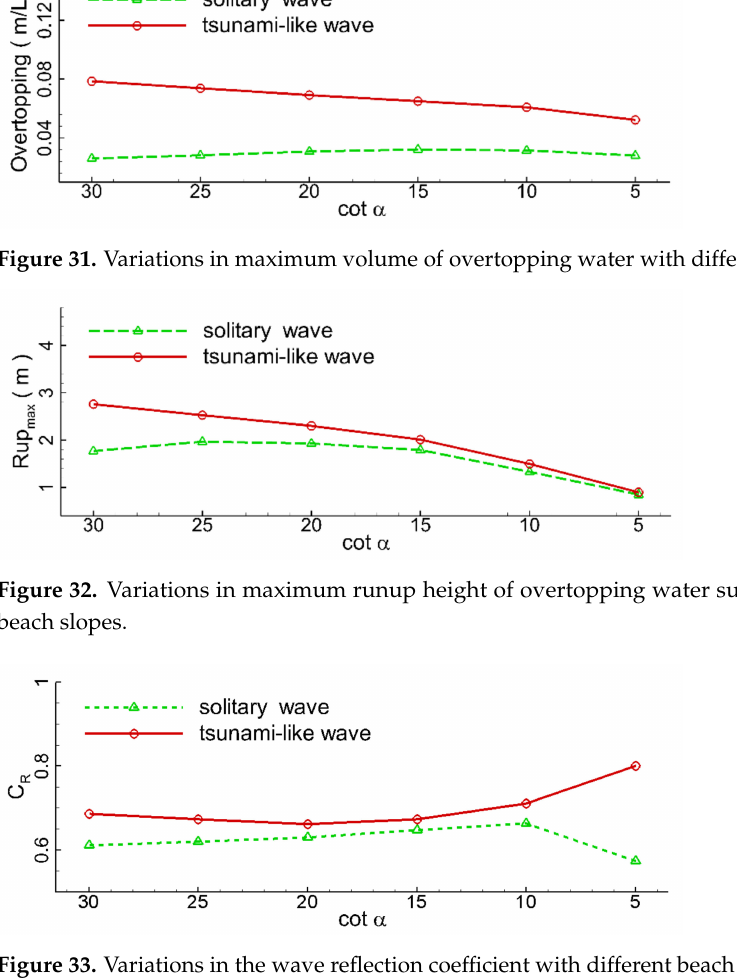
Figure 33. Variations in the wave reflection coefficient with different beach